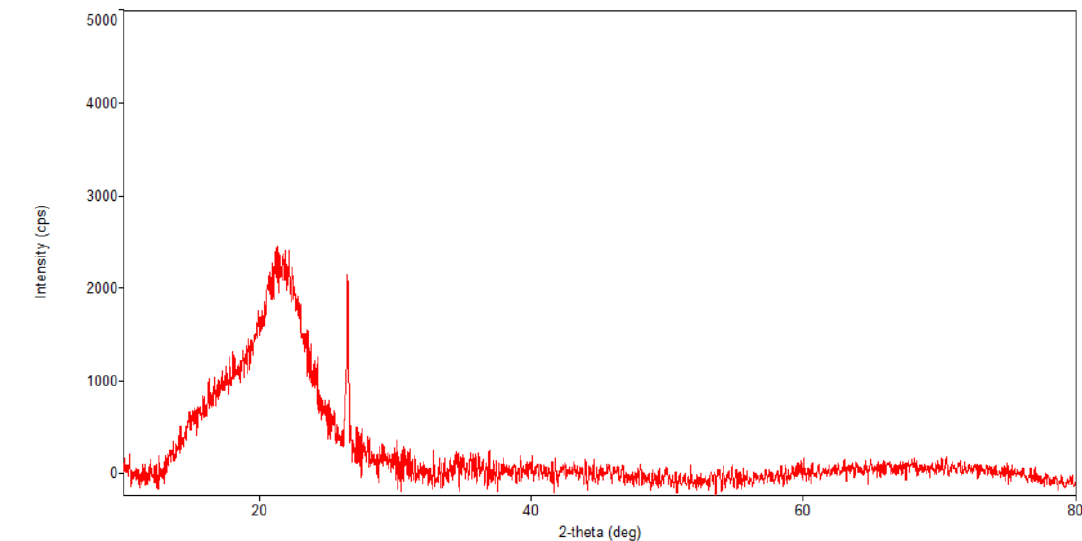
Figure 5. Powder XRD patterns of Artemisia annua.